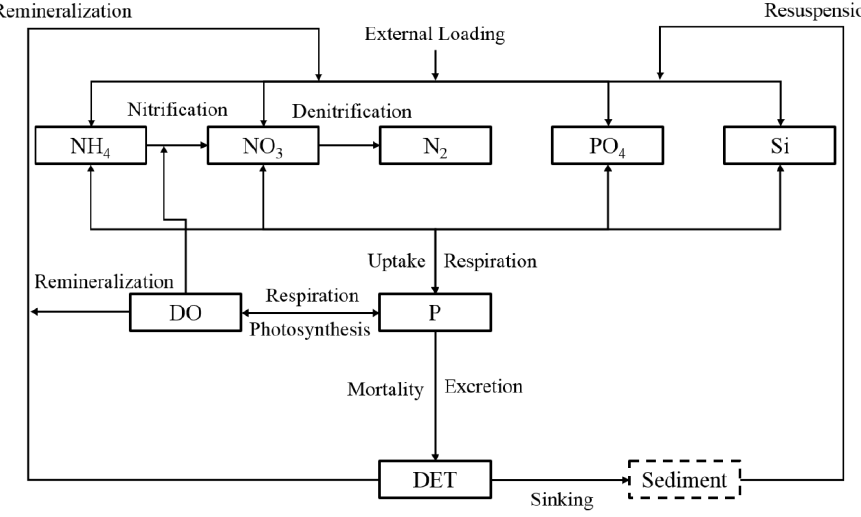
Figure 3. Schematic of the water quality model in TGR. P, DET, DO, NO 3 , NH 4 , PO 4 and Si are phytoplankton, detritus, dissolved oxygen, nitrate, ammonium, phosphate, and dissolved silicon, respectively. Table 1. The parameter values of the ecological water quality model applied in the Caotang Bay (CB). Parameter Description Value Unit